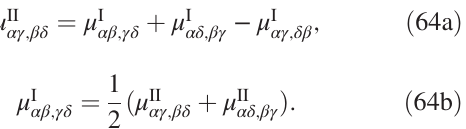
TABLE I. Quadrupole moments (in e bohr) of PbTiO 3 calcu- lated via Eq. (53). Note that Q ð